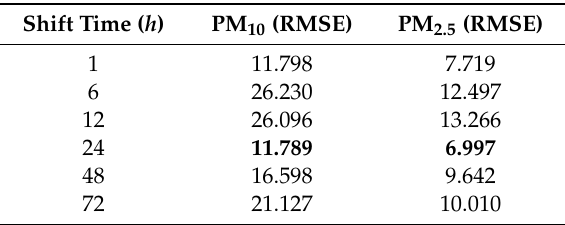
Table 4. The e ff ects of lookback